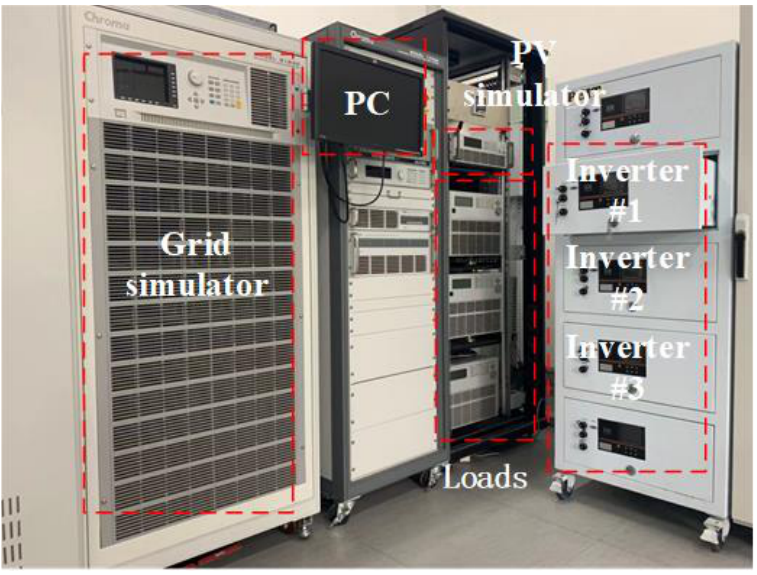
Figure 20. Experimental platform.